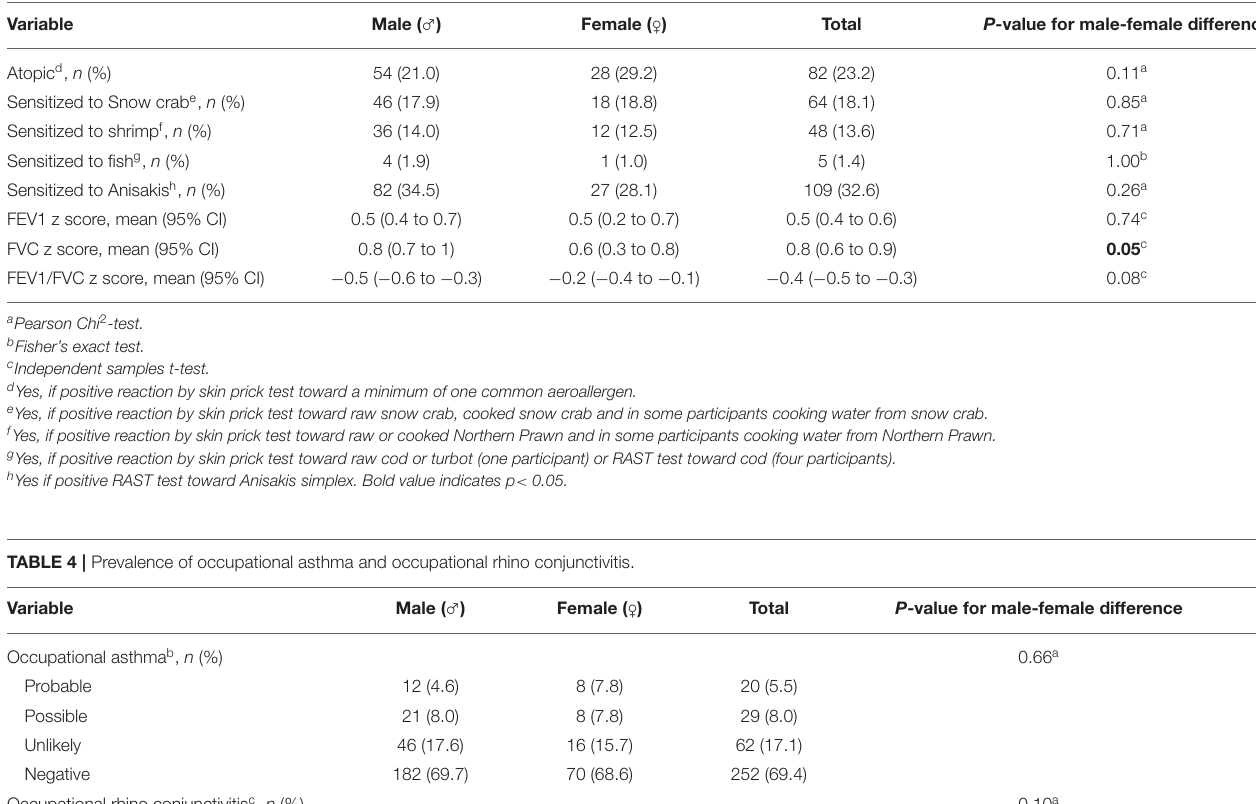
TABLE 3 | Sensitization to allergens and lung function measurements.